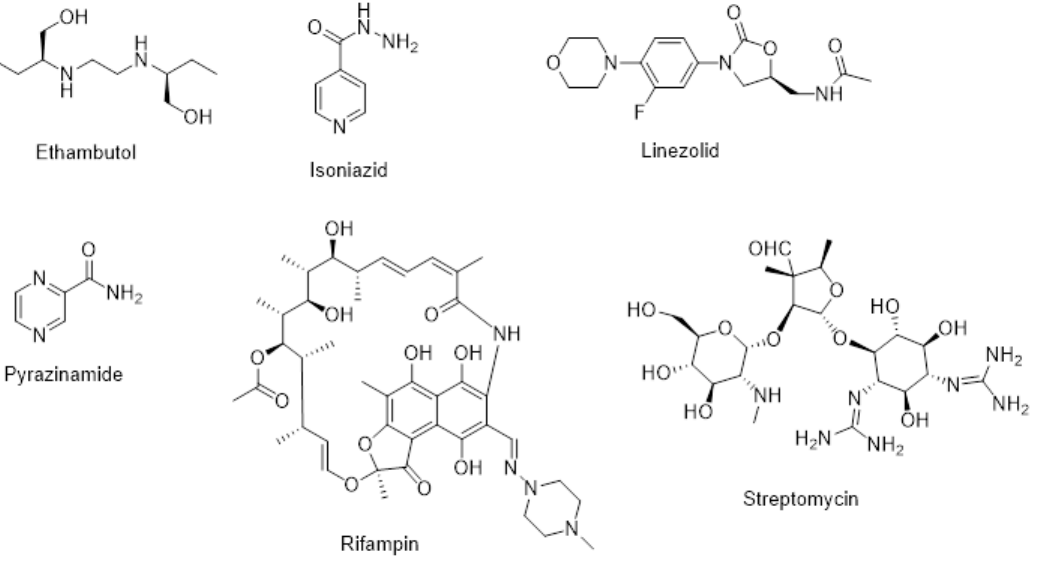
Figure 2. The chemical structure of antituberculosis drugs .